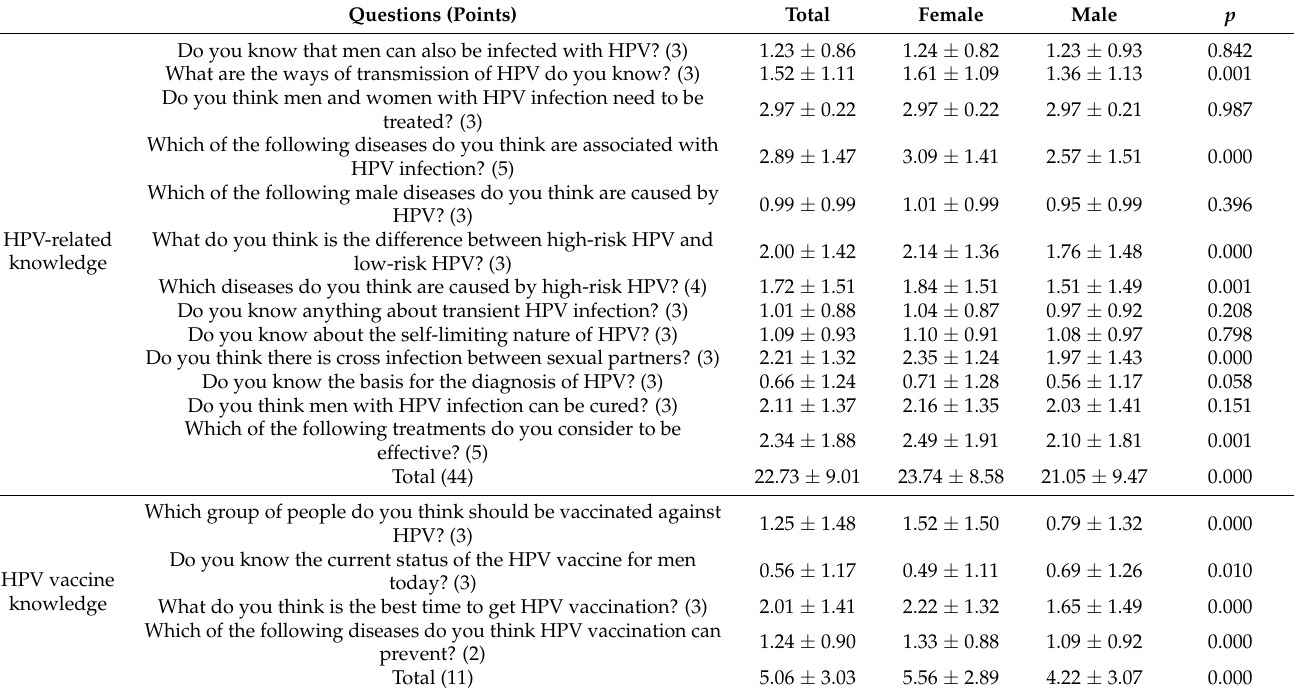
Table 2. College students’ knowledge (based on scores) of HPV (out of 44 points) and HPV vaccination (out of 11